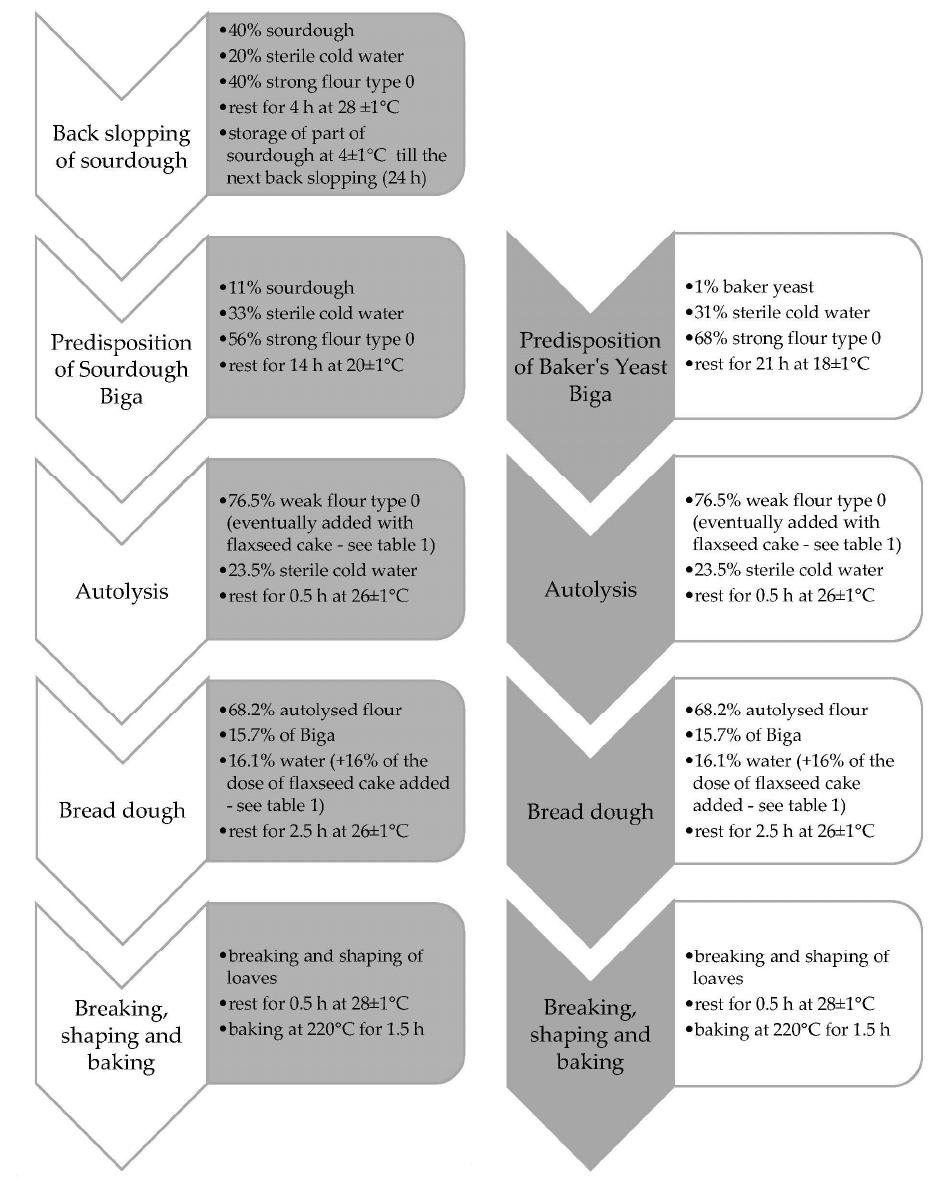
Figure 1. Back-slopping procedure, baking protocol, and operating conditions (time and temperature) adopted during the experimental research for sourdough bread (on the left) and baker’s yeast bread (on the